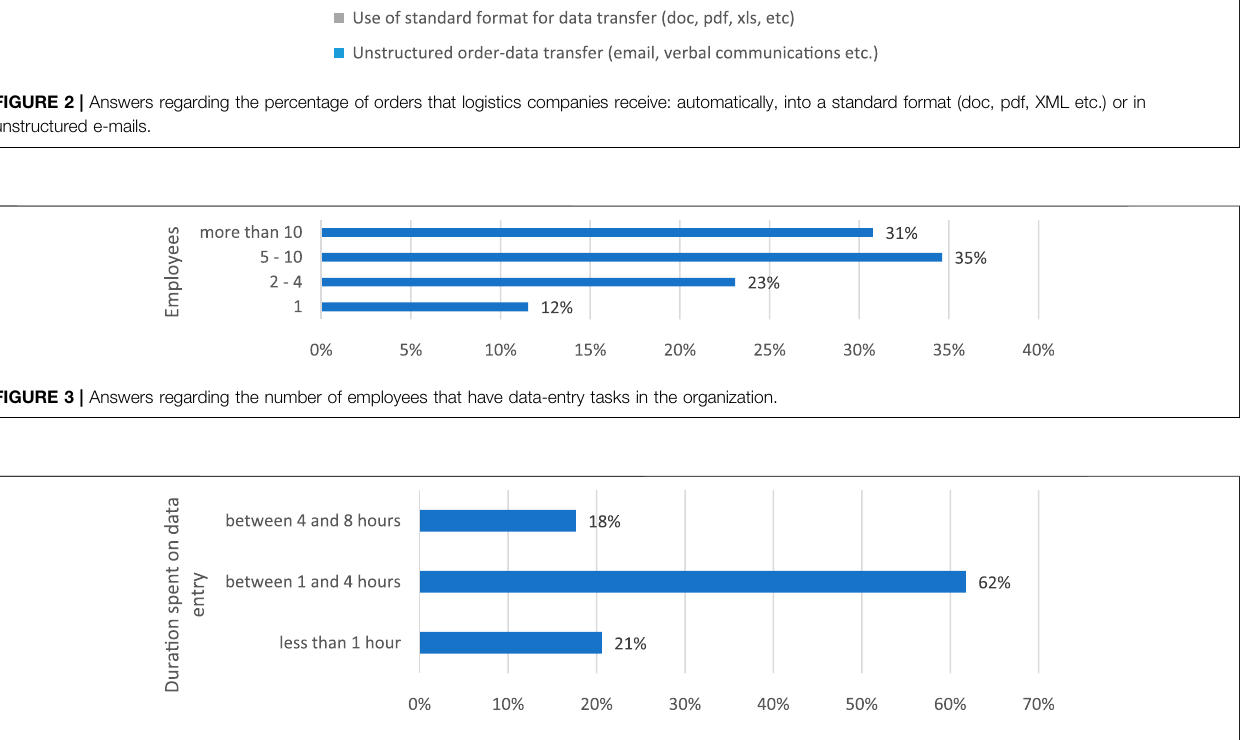
FIGURE 4 | Answers regarding the daily duration that an operator spends on data entry reported to 8 h shift-length.